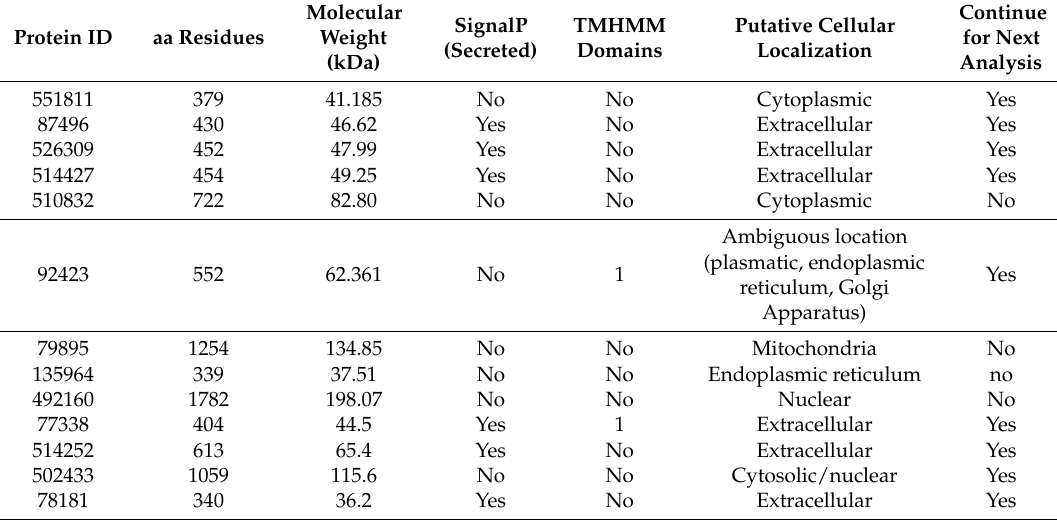
Putative Cellular Localization